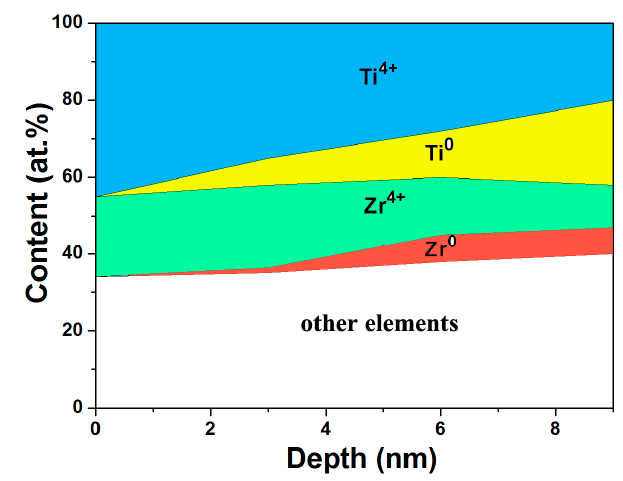
Figure 6. Schematic illustration of the compositional depth profiles of Ti and Zr oxidized states in passive films for Φ 6 mm Ti 46 Zr 20 V 12 Cu 5 Be 17 rod .